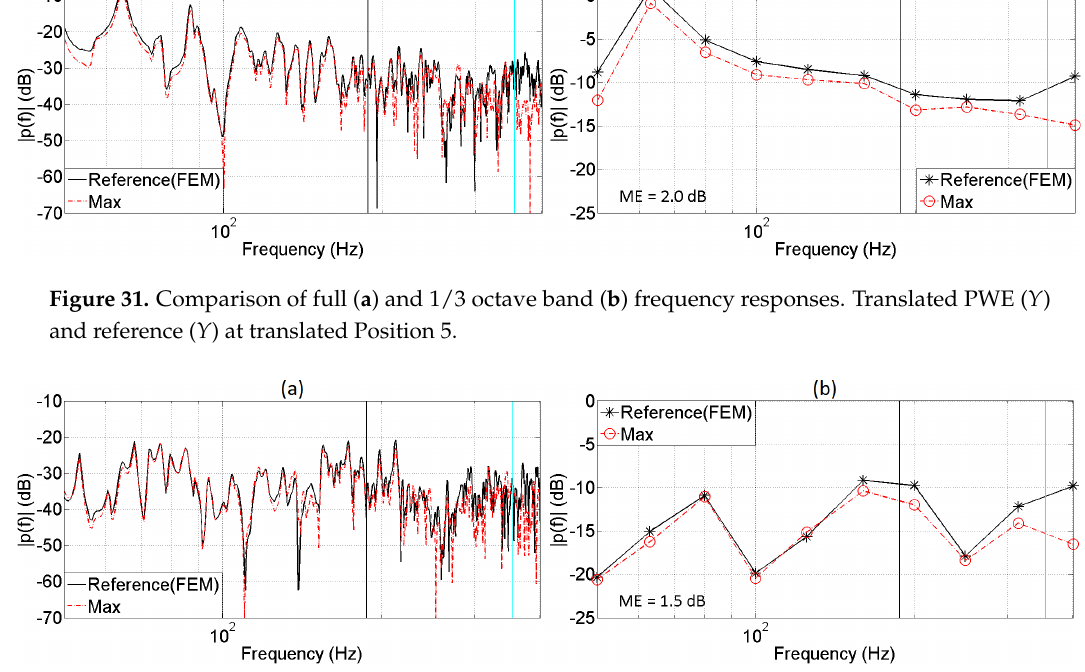
Figure 32. Comparison of full ( a ) and 1/3 octave band ( b ) frequency responses. Translated PWE ( Z ) and reference ( Z ) at translated Position 5. Table 3. Mean errors in the B-format signals for the interactive auralization at different receiver